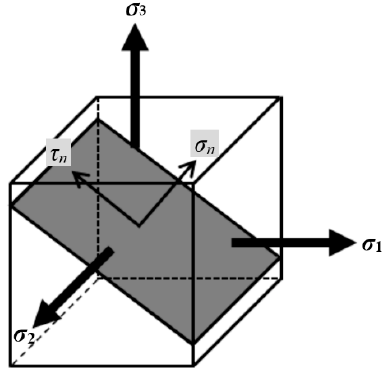
Figure 1. Stress components σ n and τ n on the fracture plane.